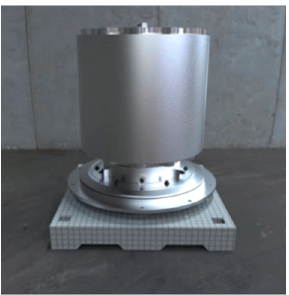
Figure 2. Rotor of flywheel used for ground based storage.